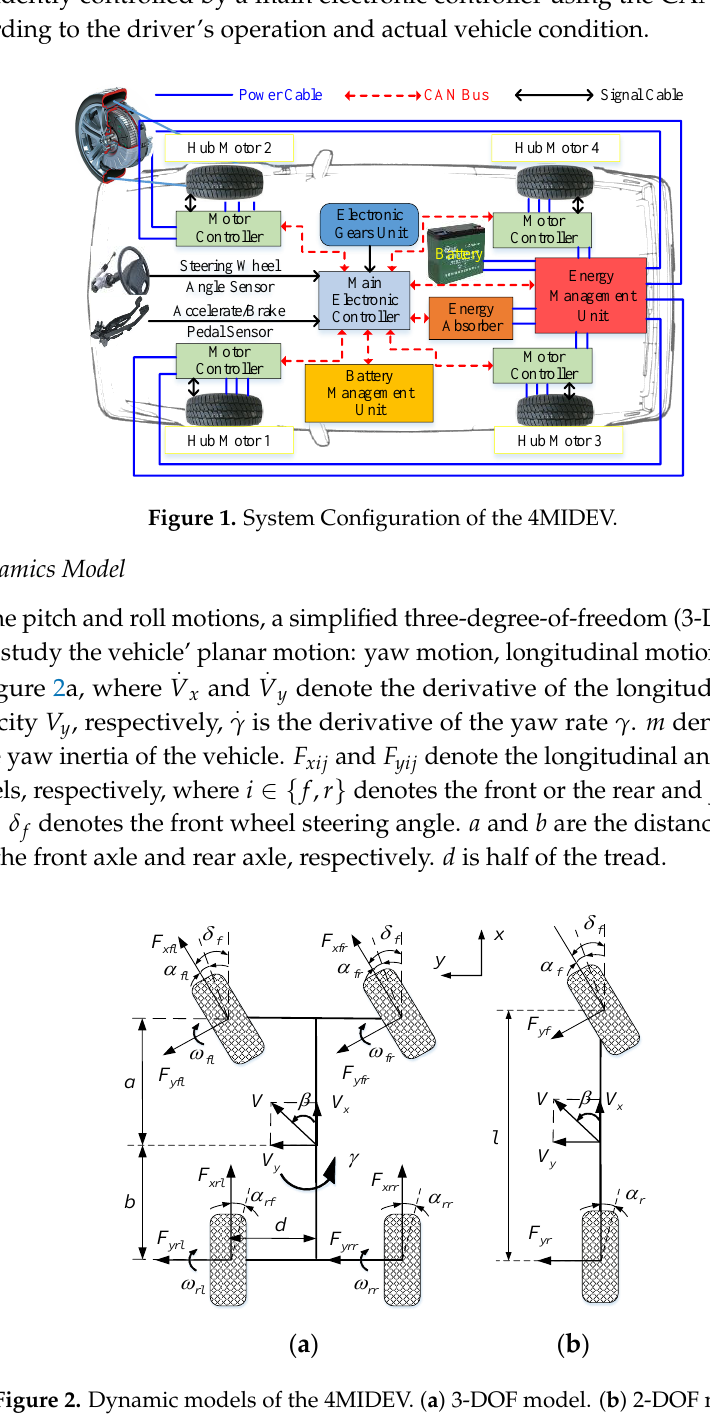
Figure 2. Dynamic models of the 4MIDEV. ( a ) 3-DOF model. ( b ) 2-DOF model.